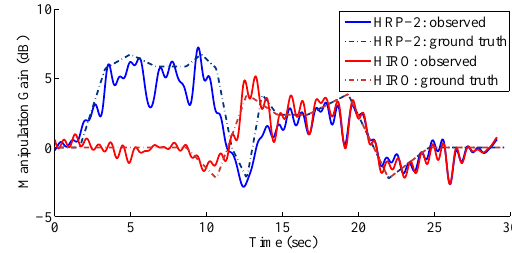
Figure 19. Observed power ratio in 800–1000 Hz band